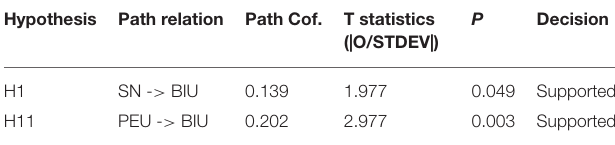
TABLE 13 | SEM path coefficients of direct hypothesis.